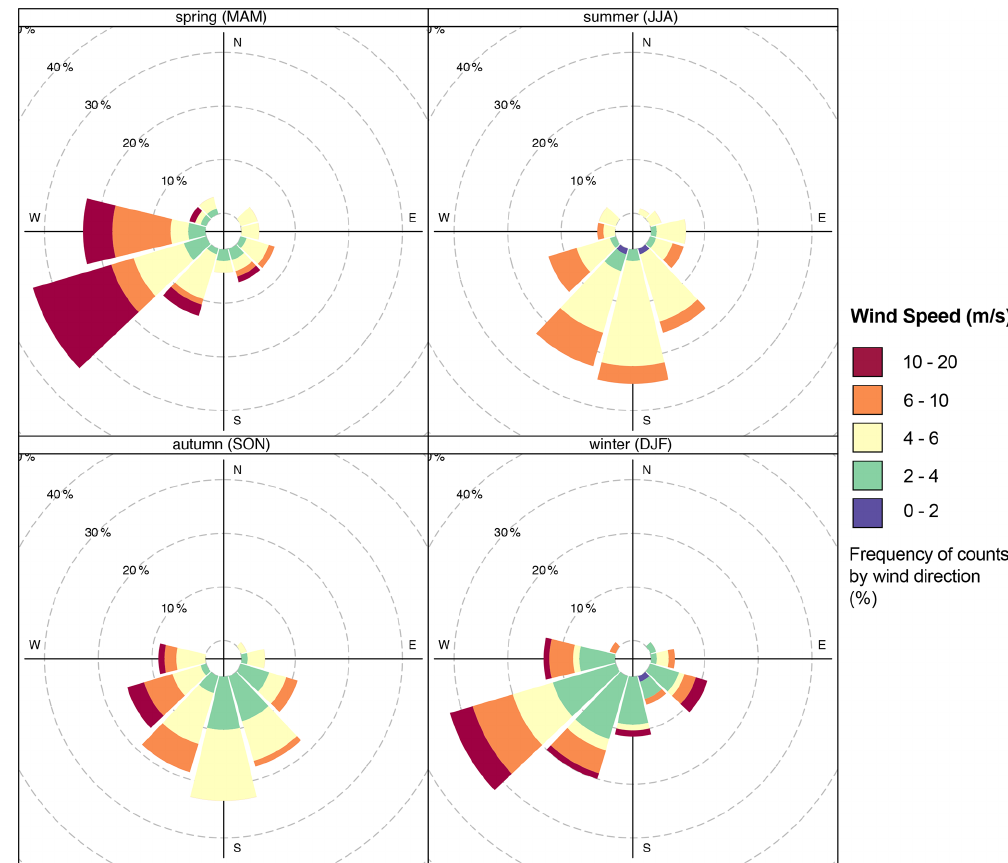
Figure 2. Seasonal wind rose plots at